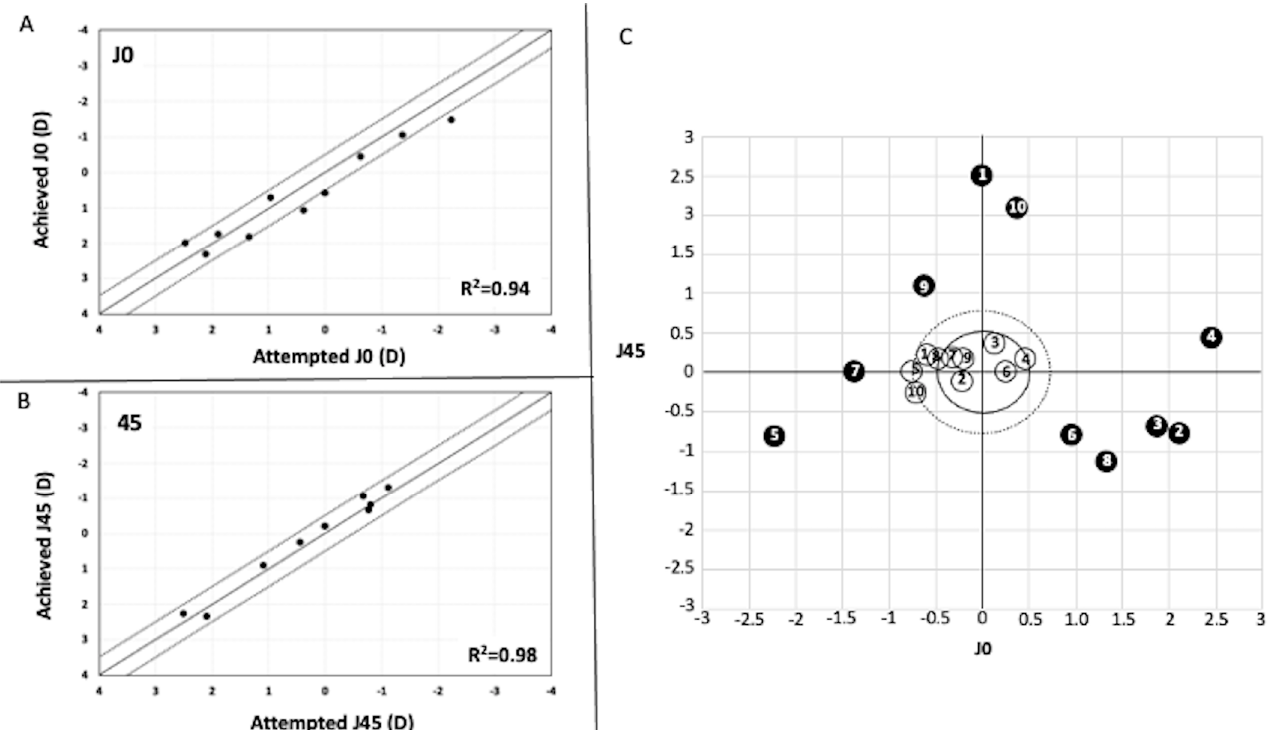
Figure 3. Plots showing the achieved against attempted correction (predictability) of the astigmatic components J0 ( A ) and J45 ( B ) of 6 months Femto-LASIK. ( C ) Representation of the astigmatic vector (J0 and J45) before surgery and 6 months after Femto-LASIK. (The area inside the dot-line circle represents a refractive cylinder ≤ − 1.5 D, and the area inside the black-line circle a refractive cylinder ≤ − 1.0 D).